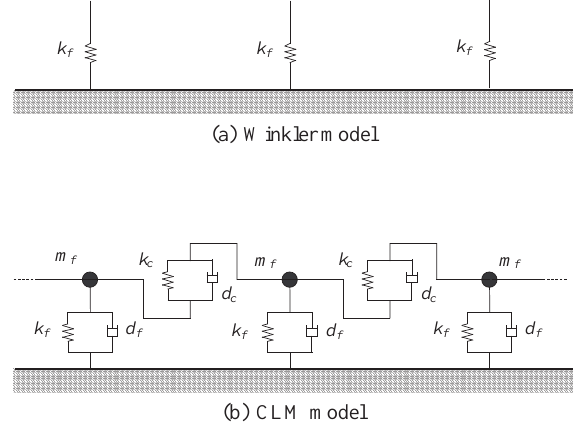
Figure 8. Foundation models (each discrete element is connected to each sleeper).